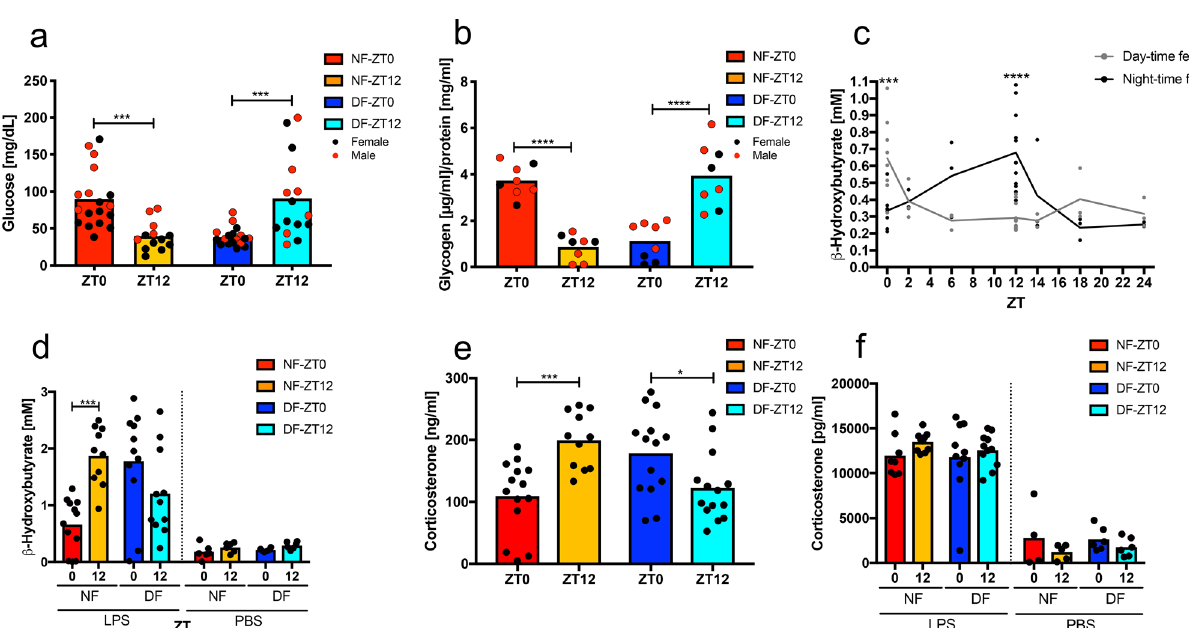
Fig. 2 Glucose metabolism parallels mortality. a Serum glucose ( p < 0.0001) 6 h post LPS (20 mg/kg) stimulation on day 5 of TRF. Female in black, male in red. NF-ZT0 N female = 11 N male = 7, NF-ZT12 N female = 8 N male = 5, DF-ZT0 N female = 11 N male = 7, DF-ZT12 N female = 9 N male = 7. Box indicates mean. Statistical signi fi cance according to two-way ANOVA and Sidak ’ s multiple comparison (ZT0 vs. ZT12) as indicated. p NF = 0.0002, p DF = 0.0007. Interaction F = 34.21, p < 0.0001, ZT F = 0.09264, ns, Feeding F = 0.03347, ns. b Liver glycogen content on day 5 of TRF measured at ZT0 or ZT12. (1,66) (1,66) (1,66) Female in black, male in red. N female = 3 N male = 5. Box indicates mean. Statistical signi fi cance according to two-way ANOVA and Sidak ’ s multiple comparisons (ZT0 vs. ZT12) as indicated. Interaction F (1,28) = 78.25, p <0.0001, ZT F (1,28) = 0.006643, ns, Feeding F (1,28) = 0.4853, ns. **** p < 0.0001. c Baseline serum levels of β -hydroxybutyrate (BHB) at the indicated ZT on day 5 of day-time (grey) or night-time feeding (black) (Interaction F (6,61) = 10.31, p < 0.0001, ZT F = 2.704, p = 0.0215, Feeding F = 0.717, p = 0.4004), N = 10, N = 3, N = 3, N = 13, N = 12, N = 3, N (6,61) (1,61) ZT0 ZT2 ZT6 DF-ZT12 NF-ZT12 ZT14 ZT18 = 3, N = 3. Each dot represents an individual data point and the line represents the mean. Females only. Statistical analysis using two-way ANOVA and ZT24 Sidak ’ s multiple comparisons (NF vs. DF). *** p = 0.0003 **** p < 0.0001. d BHB serum levels 6h post LPS on day 5 of TRF at ZT0 or ZT12 in female mice. DF-ZT0-LPS N = 11, NF-ZT0-LPS N = 12, DF-ZT12-LPS N = 11, NF-ZT12-LPS N = 11, DF-ZT0-PBS N = 6, NF-ZT0-PBS N = 6, DF-ZT12-PBS N = 6, NF-ZT12- PBS N = 6. Mean is indicated by the box. Statistical analysis using two-way ANOVA (LPS and PBS separately) and Sidak ’ s multiple comparison (ZT0 vs. ZT12) as indicated. LPS: Interaction F (1,40) = 18.29, p <0.0001, ZT F (1,40) = 2.357, ns, Feeding F (1,40 ) = 1.184, ns. PBS: Interaction F (1,20) = 0.001053, ns, ZT F (1,20) = 5.015, p = 0.0367, Feeding F = 0.9777, ns. *** p = 0.0004. e , f Serum corticosterone on day 5 of TRF at baseline ( e ) (Interaction F (1,49) = (1,22) 20.36, p <0.0001, ZT F (1,49) = 1.159, ns, Feeding F (1,49) = 0.05739, ns, * p = 0.0305 *** p = 0.0007, DF-ZT0 N = 14, DF-ZT12 N = 14, NF-ZT0 N = 14, NF- ZT12 N = 11) or 6 h post LPS (20 mg/kg)/PBS control stimulation ( f ) (LPS and PBS ns, DF-ZT0-LPS N = 10, DF-ZT12-LPS N = 11, NF-ZT0-LPS N = 8, NF- ZT12-LPS N = 10, DF-ZT0-PBS N = 6, DF-ZT12-PBS N = 6, NF-ZT0-PBS N = 4, NF-ZT12-PBS N = 5) in female mice. Box indicates mean. Statistical analysis using two-way ANOVA (LPS and PBS separately) and Sidak ’ s multiple comparison (ZT0 vs. ZT12) as